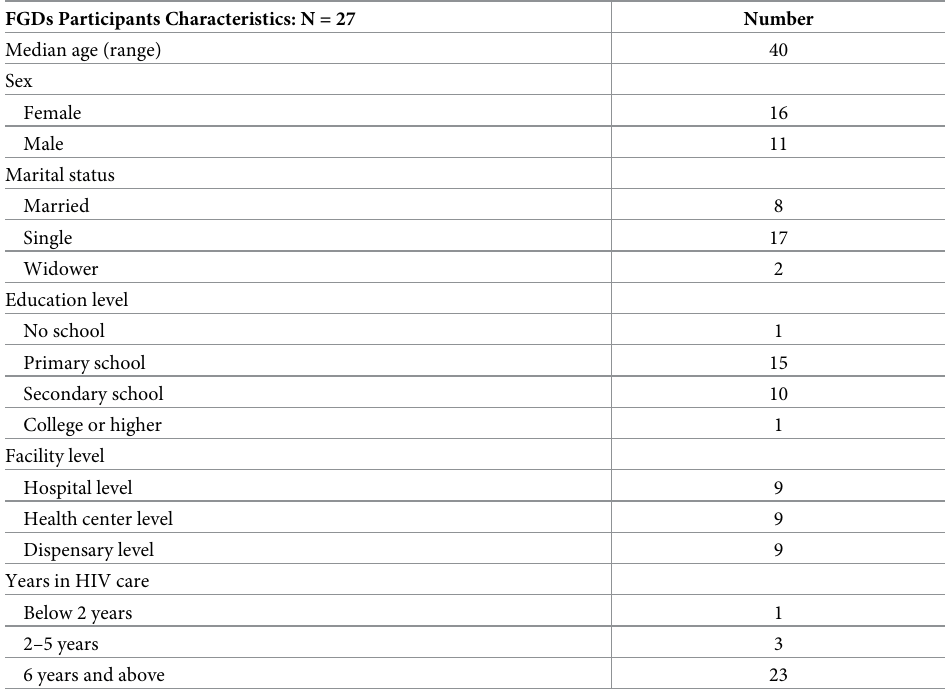
Table 4. Characteristics of the FGDs participants. FGDs Participants Characteristics: N =